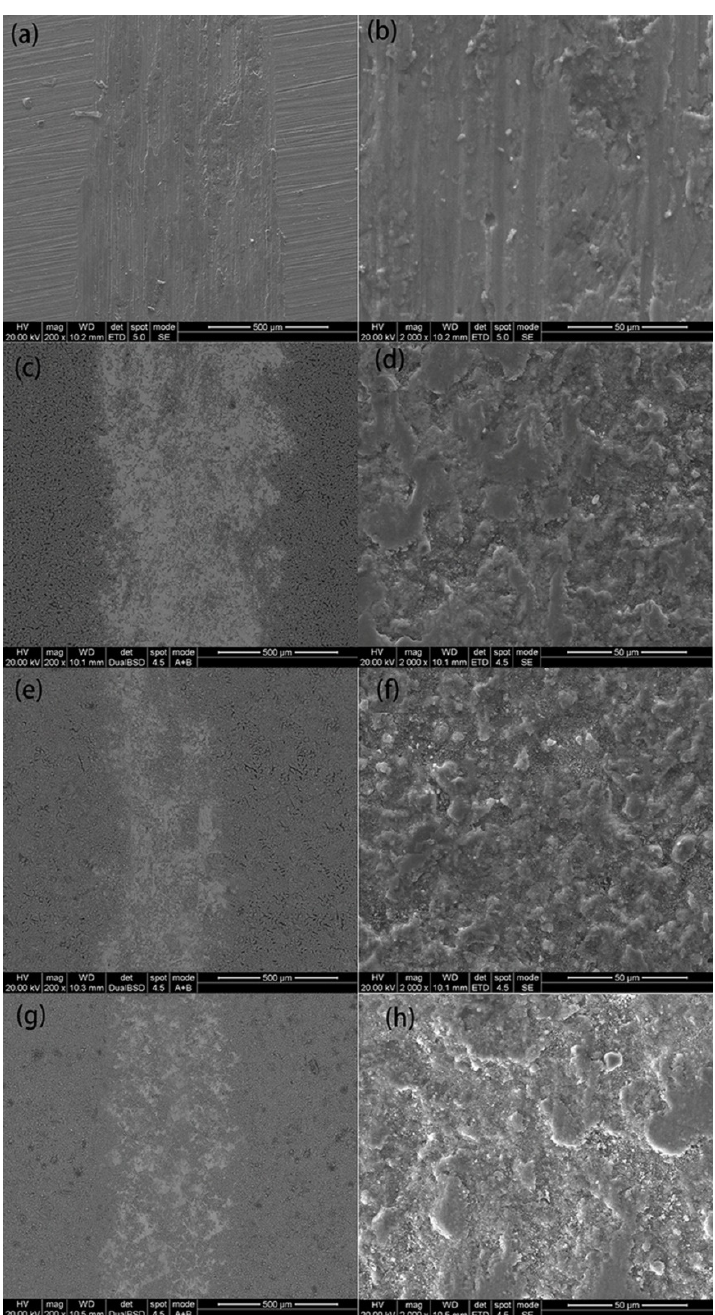
Figure 6. SEM morphologies of the wear tracks after 15 min of wear under 4 N: ( a , b ) Al-Zn-Mg-Cu alloy, ( c , d ) coating A, ( e , f ) coating B and ( g , h ) coating C.